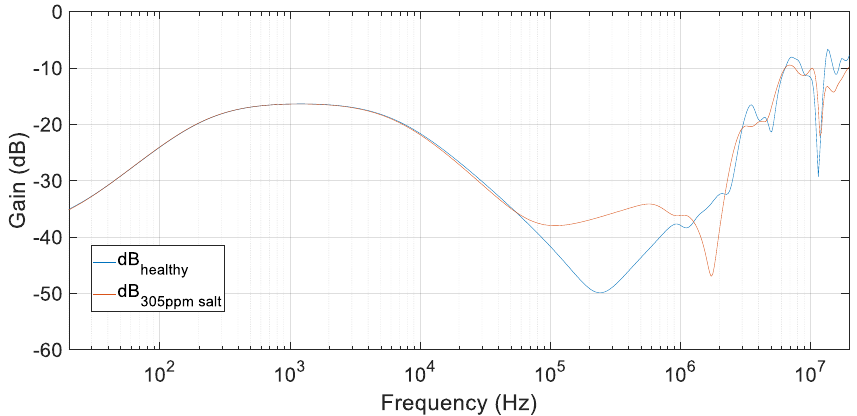
Figure 15. FRA tests for a transformer with distillated water core with salt. Tests compare distilled water and water with 305 ppm of salt.